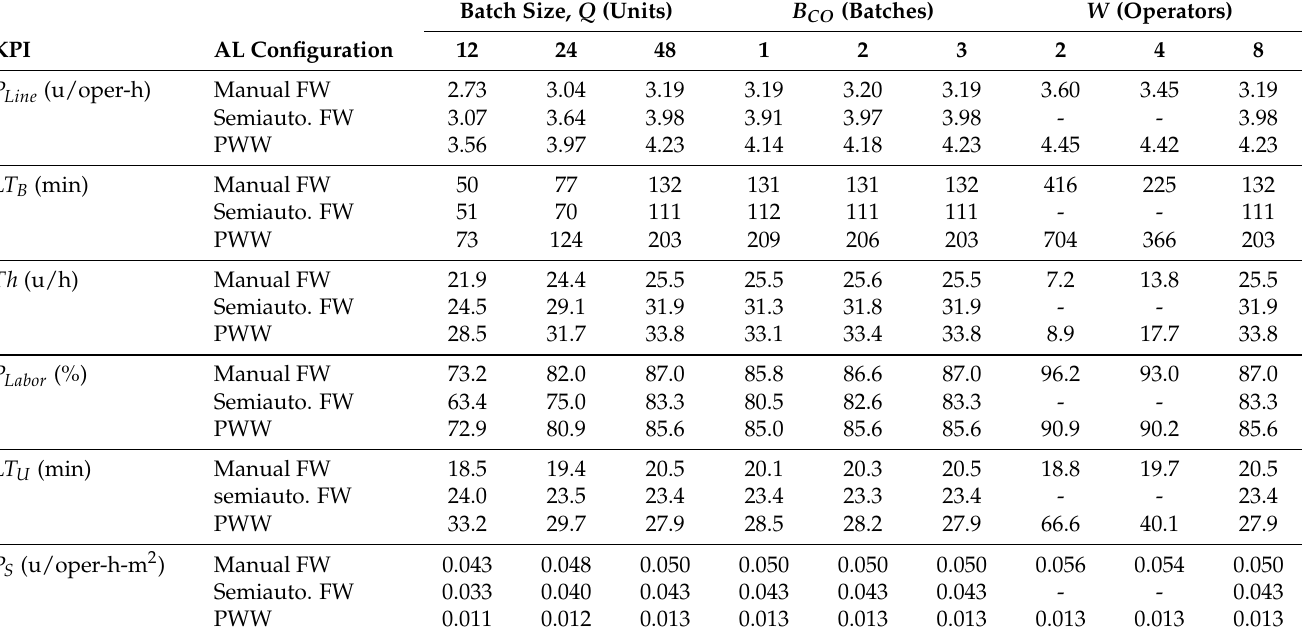
Table 10. Operational KPIs of manual FWAL, semiautomatic FWAL, and PWWAL for reduced batch size ( Q , scenario ii ), reduced no. of batches until product family changeovers ( B CO , scenario iii ), and reduced no. of workers ( W , scenario iv ). Batch Size, Q (Units) B CO (Batches) W